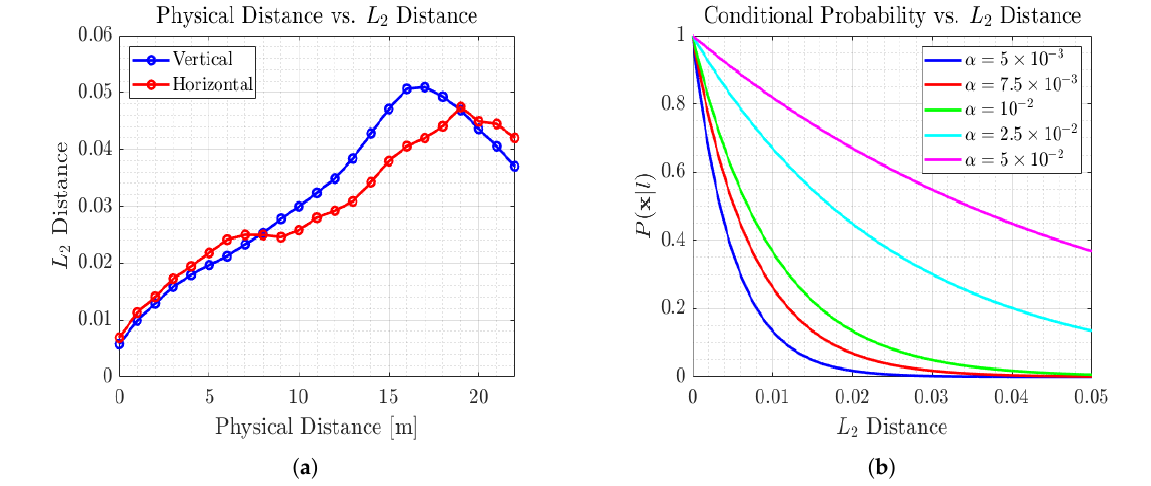
Figure 4. Evaluating 3D CSI relationship between spatial separation of training points in the indoor environment and L 2 distance of all training points as a function of space and the conditional probability of the P k NN. ( a ) L 2 distance between all training points. ( b ) Conditional probability relationship between scaling parameter α and L 2